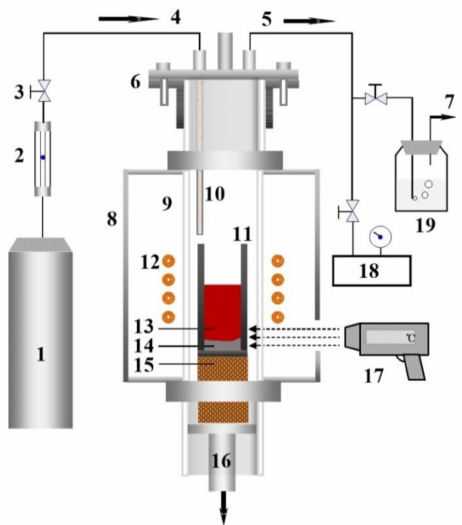
Figure 1. Schematic of electromagnetic directional solidification setup: (1) Ar gas (99.999%) tank; (2) gas flow meter; (3) two-way valve; (4) Ar gas inlet; (5) Ar gas outlet; (6) flange; (7) gas outlet; (8) stainless steel; (9) quartz tube; (10) corundum tube; (11) graphite crucible; (12) induction coil; (13) Mg–Si melt; (14) solidified Mg 2 Si crystals; (15) refractory; (16) drawing bar; (17) infrared pyrometer; (18) vacuum pump; (19) glass